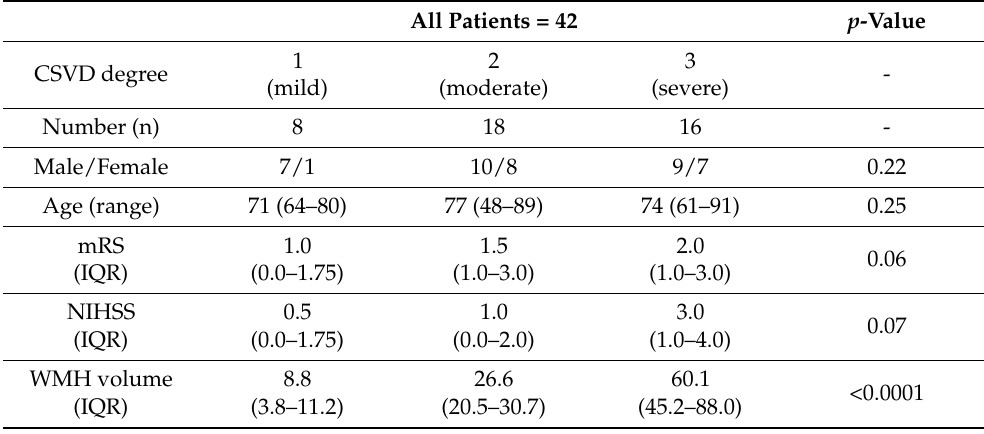
Table 1. Patients’ characteristics. CSVD = cerebral small vessel disease; IQR = interquartile